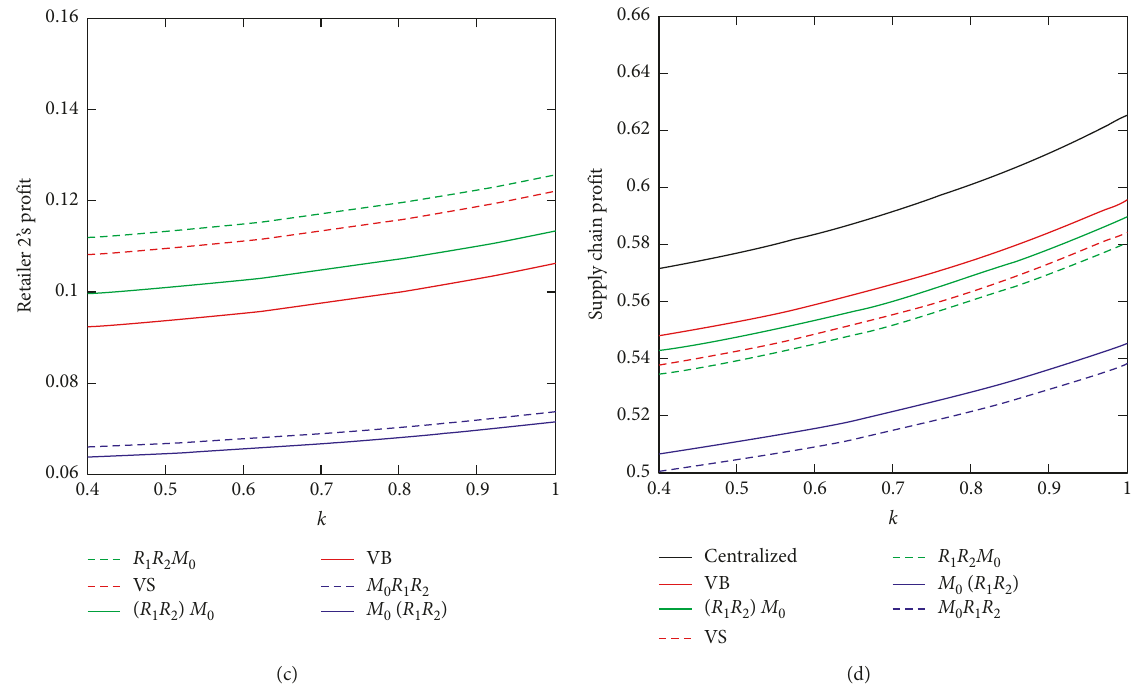
Figure 4: Effect of k on the profits in centralized and decentralized models.